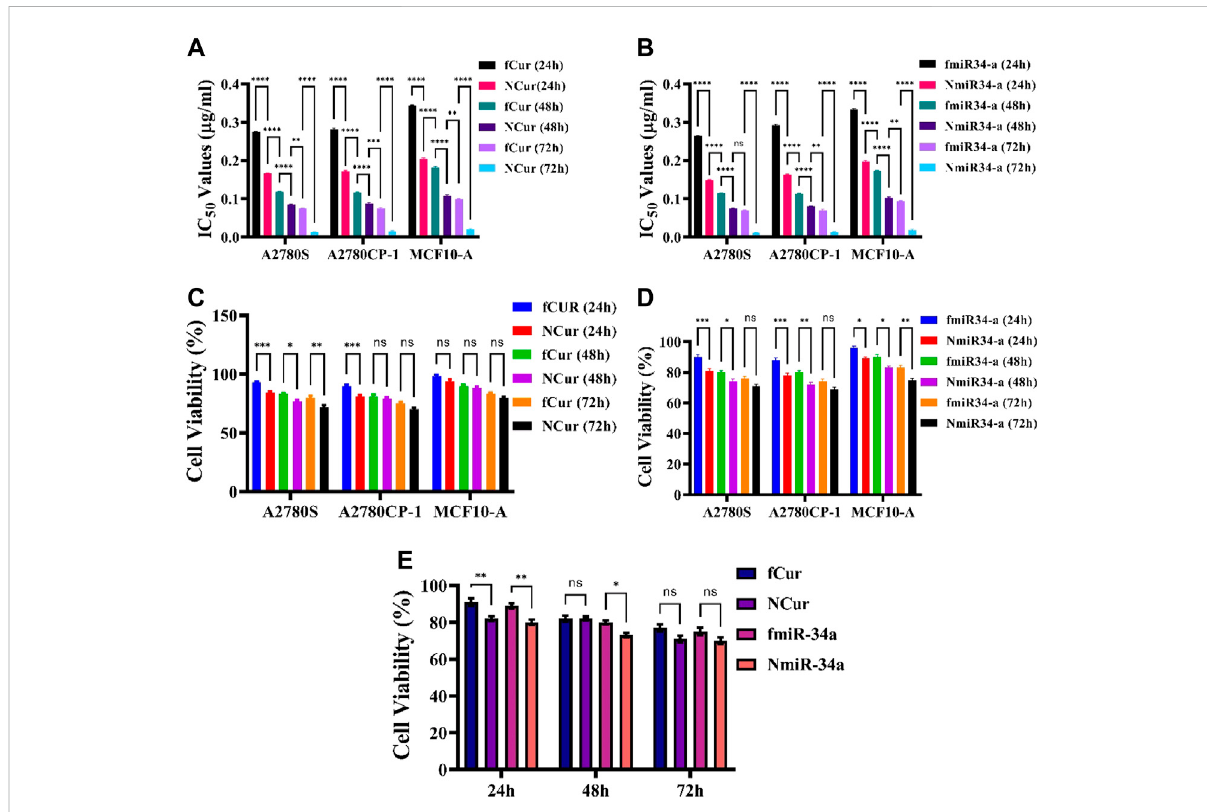
FIGURE 4 (A,B) IC 50 values of freeand niosomalCurand miRNA on healthyand cancerous cells in24, 48, and 72 h, respectively. (C,D) Cytotoxicity of free andniosomalCurandmiRNAonchealthyandcancerouscellsin24,48,and72 h,respectively. (E) AcomparisonbetweenfreeandniosomalCurand miRNA in 24, 48, and 72